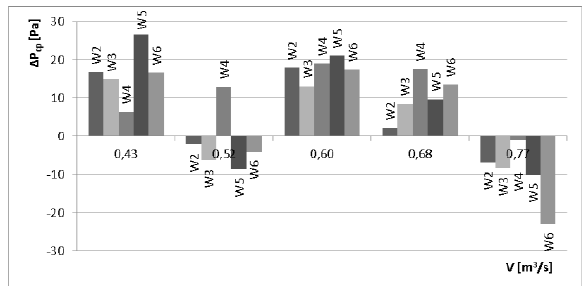
Fig. 3. Relative change in total pressure